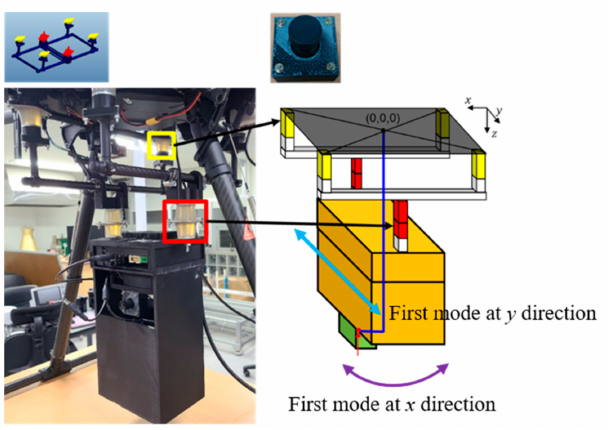
Figure 8. Optimal design of vibration